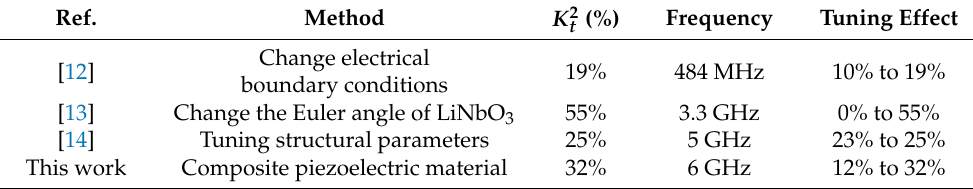
Table 1. Comparison of the tuning effectiveness between our work and previous works. Ref.